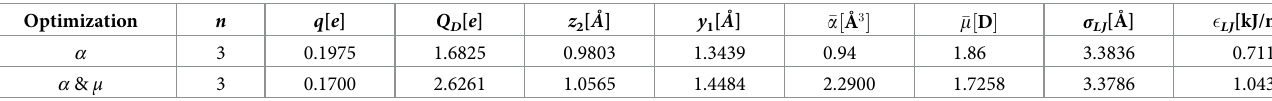
Table 3. Parameters of the 3-point polarizable water models.